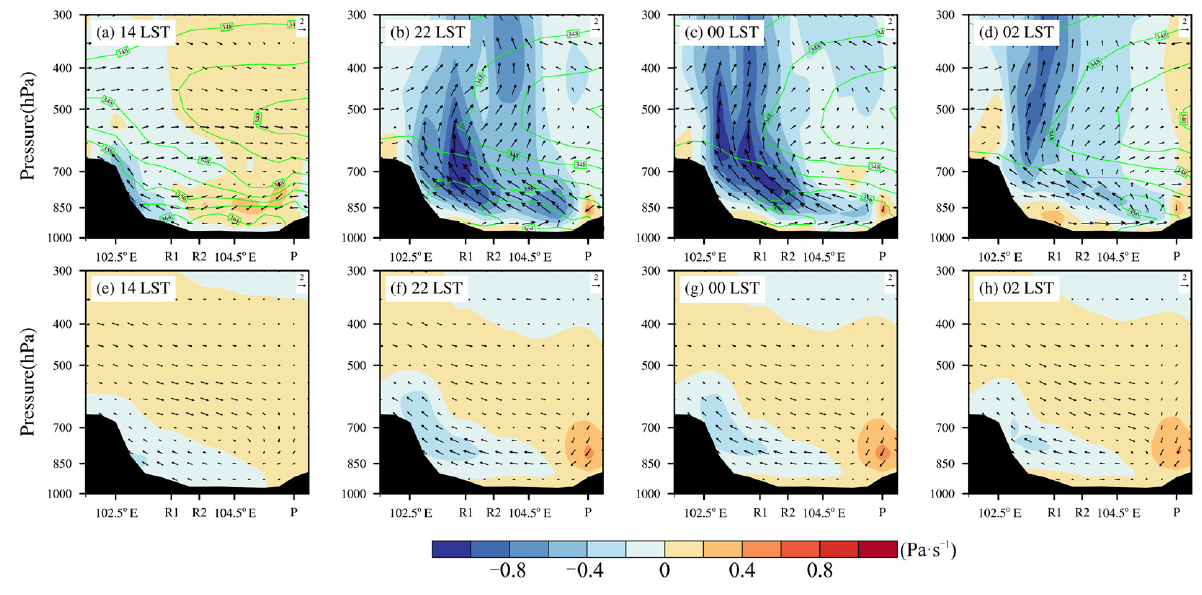
Figure 11. Vertical cross-sections along line L in Figure 1, ( a – d ) the total vertical velocity overlay the equivalent potential temperature ( θ e) (green contours), ( e – h ) the vertical velocity forced by the total creeping flow.